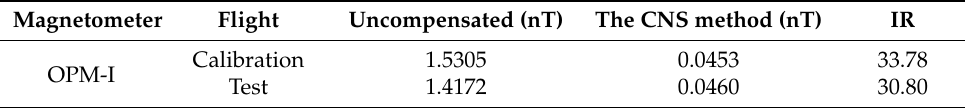
Table 4. Standard deviation and IR of the proposed CNS method.